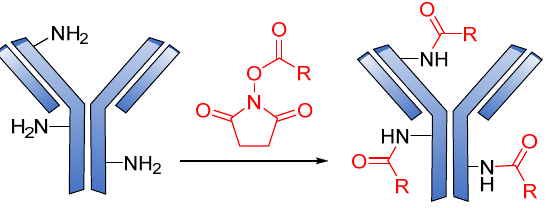
Figure 17. The mechanism for the formation of amide attachment sites through N -hydroxysuccin- Figure 17. imide (NHS).